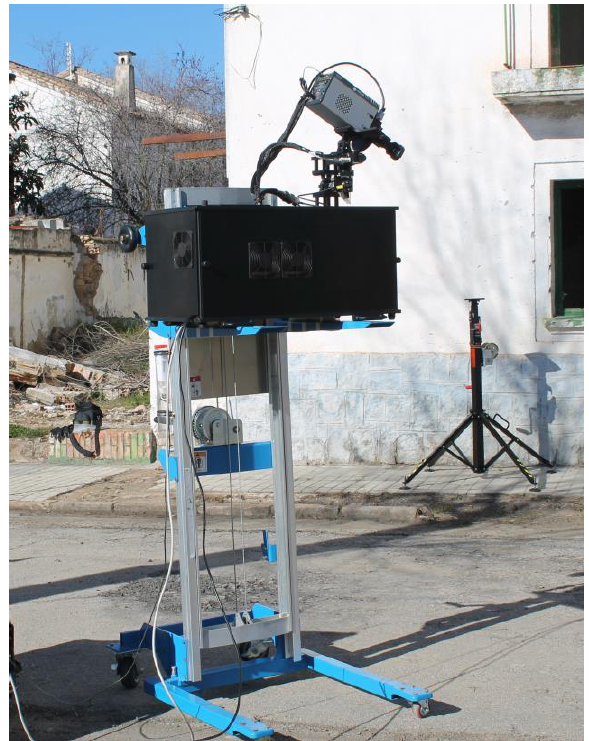
Figure 4. The LIF sensor operating in the field. It is placed on a manual mobile elevator for easy deployment. Table 2. Final system characteristics.